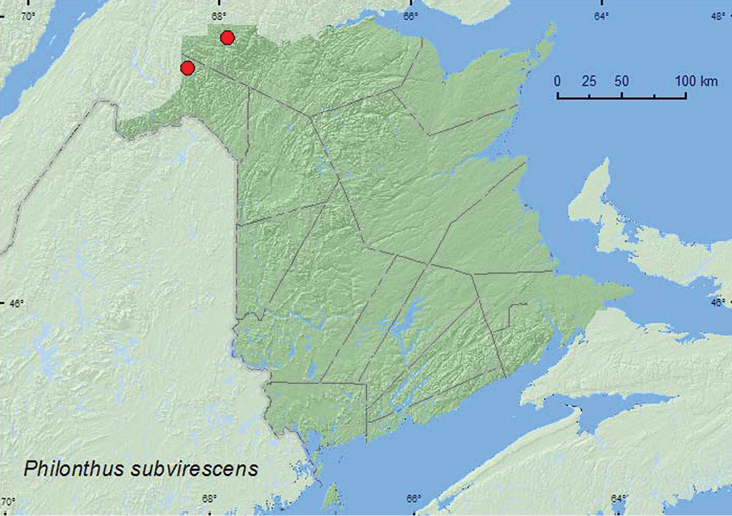
Collection localities in New Brunswick, Canada of Philonthus subvirescens.